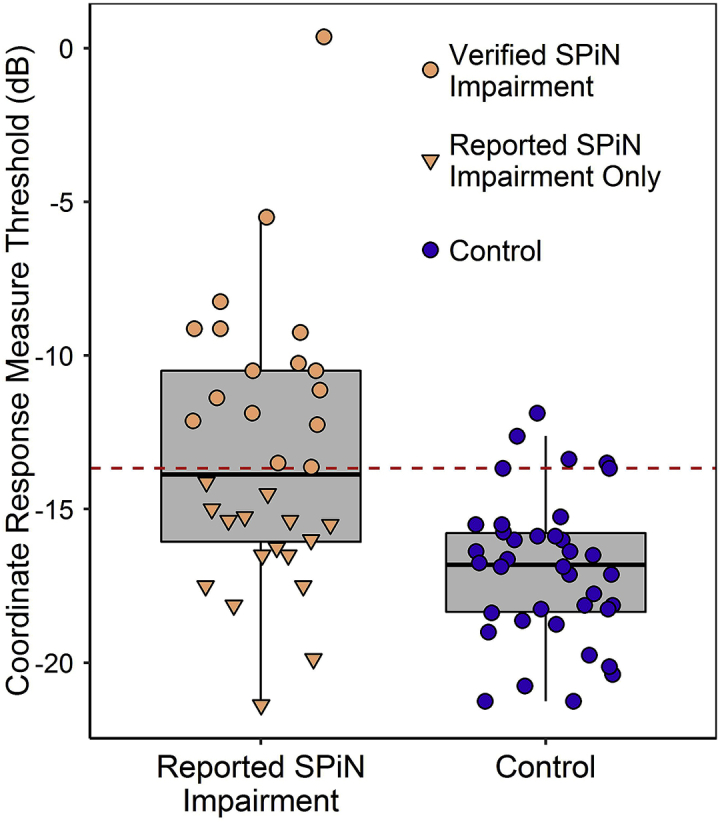
Thresholds recorded for the CRM: a measure of SPiN involving high sound levels, multiple talkers, and spatial cues. Points correspond to individual participants, upper and lower hinges to first and third quartiles, upper whiskers to the highest value within 1.5 * IQR of the upper hinge (where IQR is the interquartile range), and lower whiskers to the lowest value within 1.5 * IQR of the lower hinge. The horizontal dashed line represents the criterion for inclusion in the verified-SPiN-impairment group: thresholds at or above the 90th percentile of control thresholds.